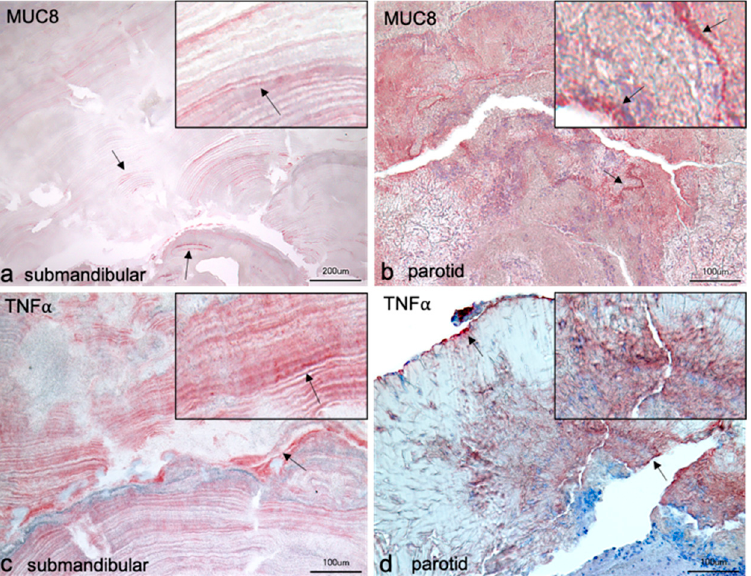
Figure 2. Immunohistochemical localization of MUC8 ( a , b ) and TNF α ( c , d ) in salivary stones from the excretory ducts of the submandibular and parotid glands. The sections of the submandibular stones show layered arrangements. The structure in a is comparable to the switching lamellae of bone; different areas show radially arranged layers around supposedly their own centers. In contrast, the structure in c is reminiscent of the annual rings of trees, as here the layers appear to be arranged around a single center. The antibody against MUC8 reacts positively in individual layers, but alternately shows no signals in other layers. In layers with stronger reactions, punctate granule-like signals are observable (arrows and insert in a ). These granule-like signals in the layers are also visible with the antibody against TNF α (arrows and insert in c ). In the lower third of the image, a slight increase in reactivity of the red-stained layers is visible in c from bottom to top until a band of blue-stained cell nuclei is seen. No positive signals for TNF α occur in the region of the cell nuclei. In the remaining part of the stone, very distinct layers are seen interspersed with cloud-like amor- phous parts. Positive MUC8 reactions occur almost throughout the section of the parotid stone ( b ). A band of stronger reactivity can be seen, containing cell nuclei (arrows and insert in b ). The positive MUC8 signals appear as cloudy shading. Areas with crystalline structure do not show positive re- sponses. The parotid stone in d shows predominantly crystalline structures, which also do not give positive signals. Intense bands at the stone edge and within the stone with intercalated cell nuclei are visible (arrows in d ).